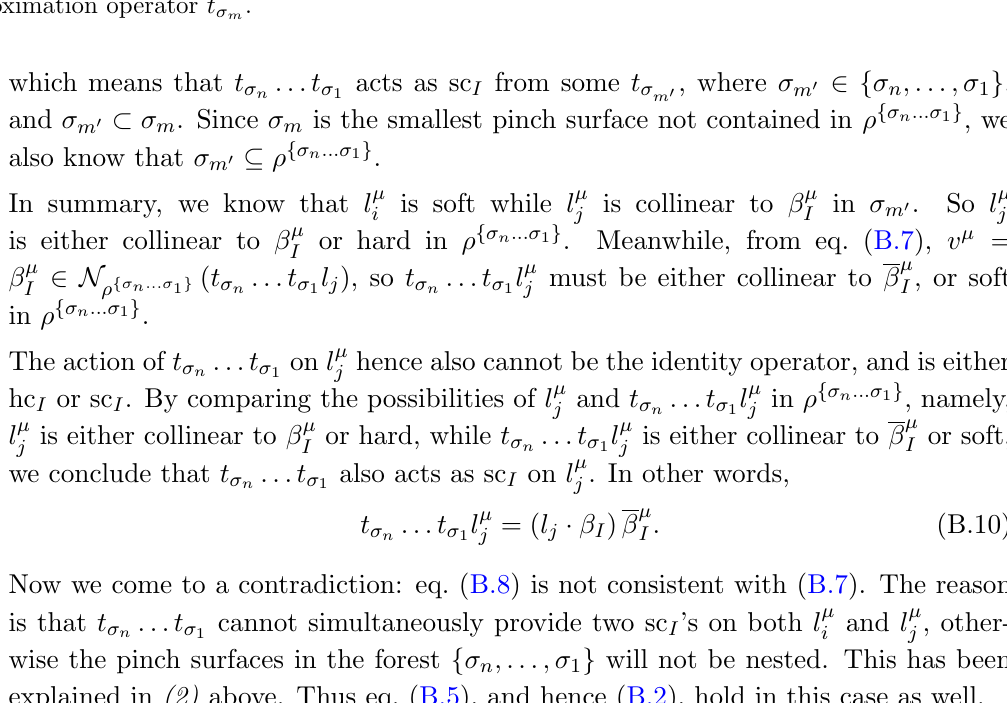
or l (cid:22) (or both) are projected by the i j